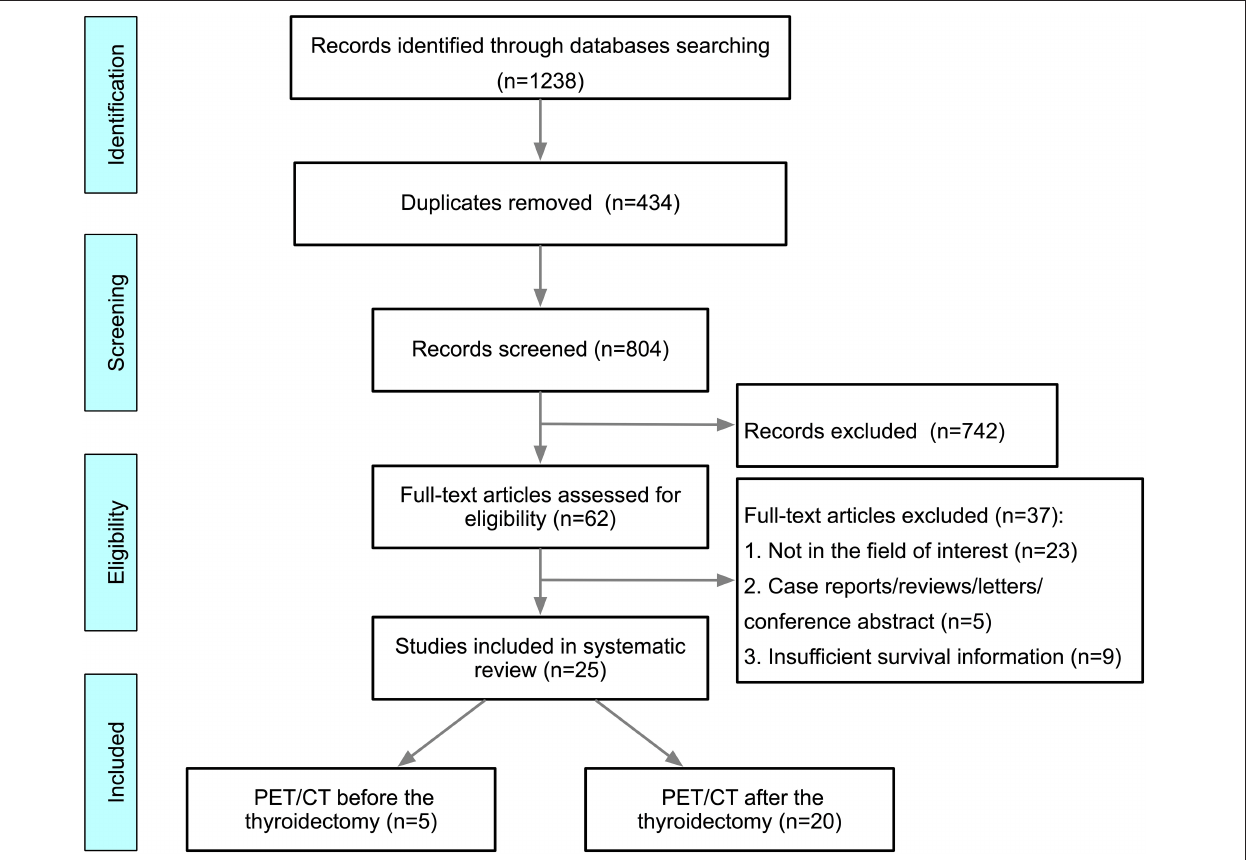
FIGURE 1 | Flow diagram of the studies included in the current systematic